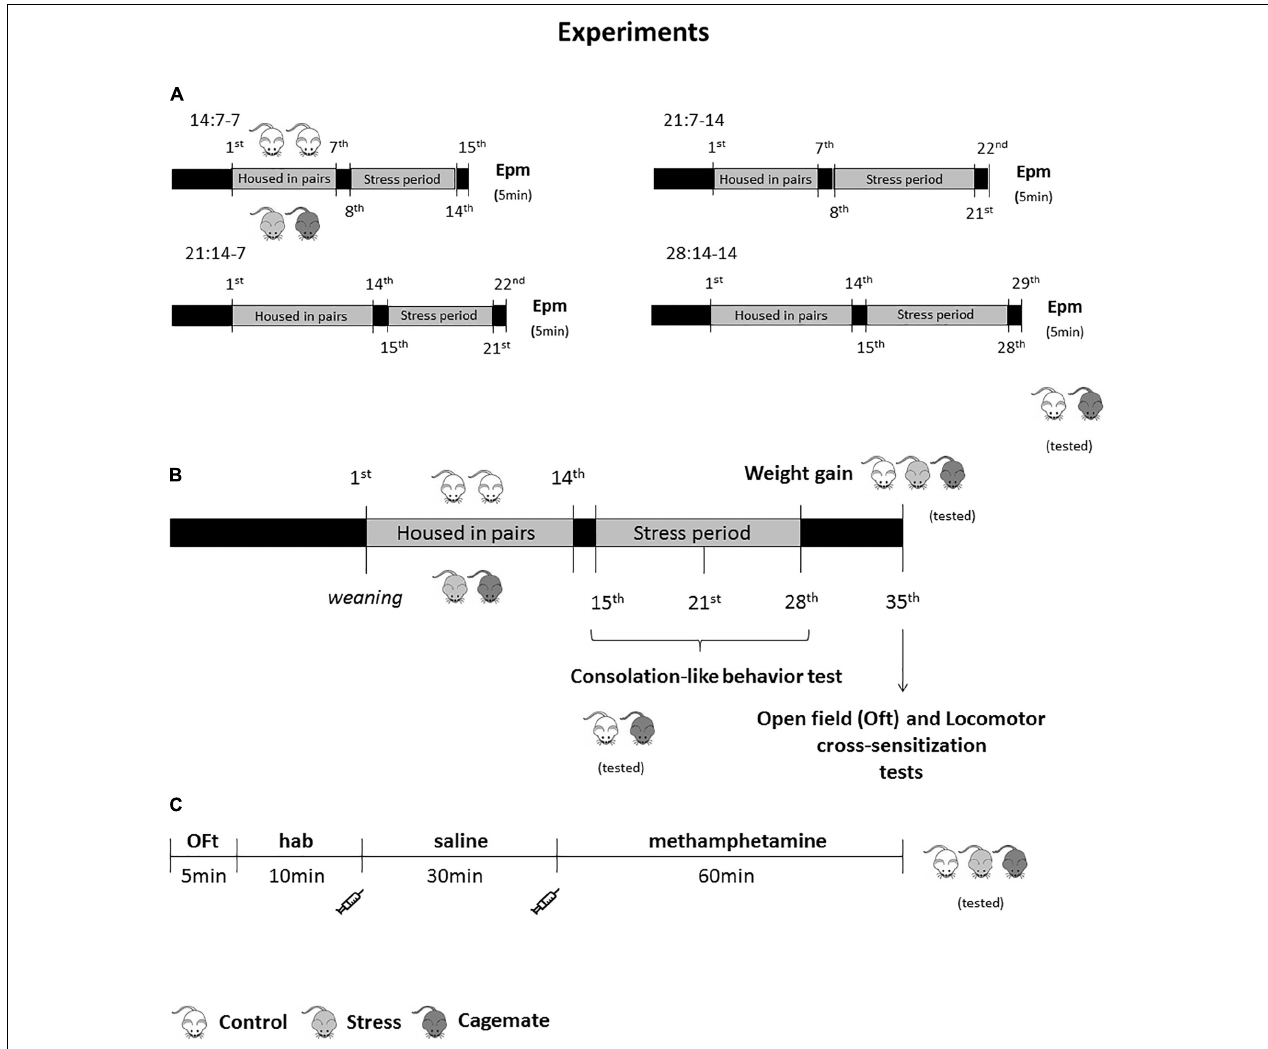
FIGURE 1 | Schematic representation of the experimental protocol. (A) Procedure performed for the test of the time-period required to establish the familiarity and to induce anxiety through chronic stress (tested groups: control and cagemate); (B) timeline regarding the procedure used to evaluate consolation-like behavior (tested groups: control and cagemate), weight gain (tested groups: control, stress, and cagemate), anxiety-like behavior in the OFt and locomotor cross-sensitization induced by methamphetamine; (C) timeline referring to open field and cross-sensitization in the test-day (tested groups: control, stress, and